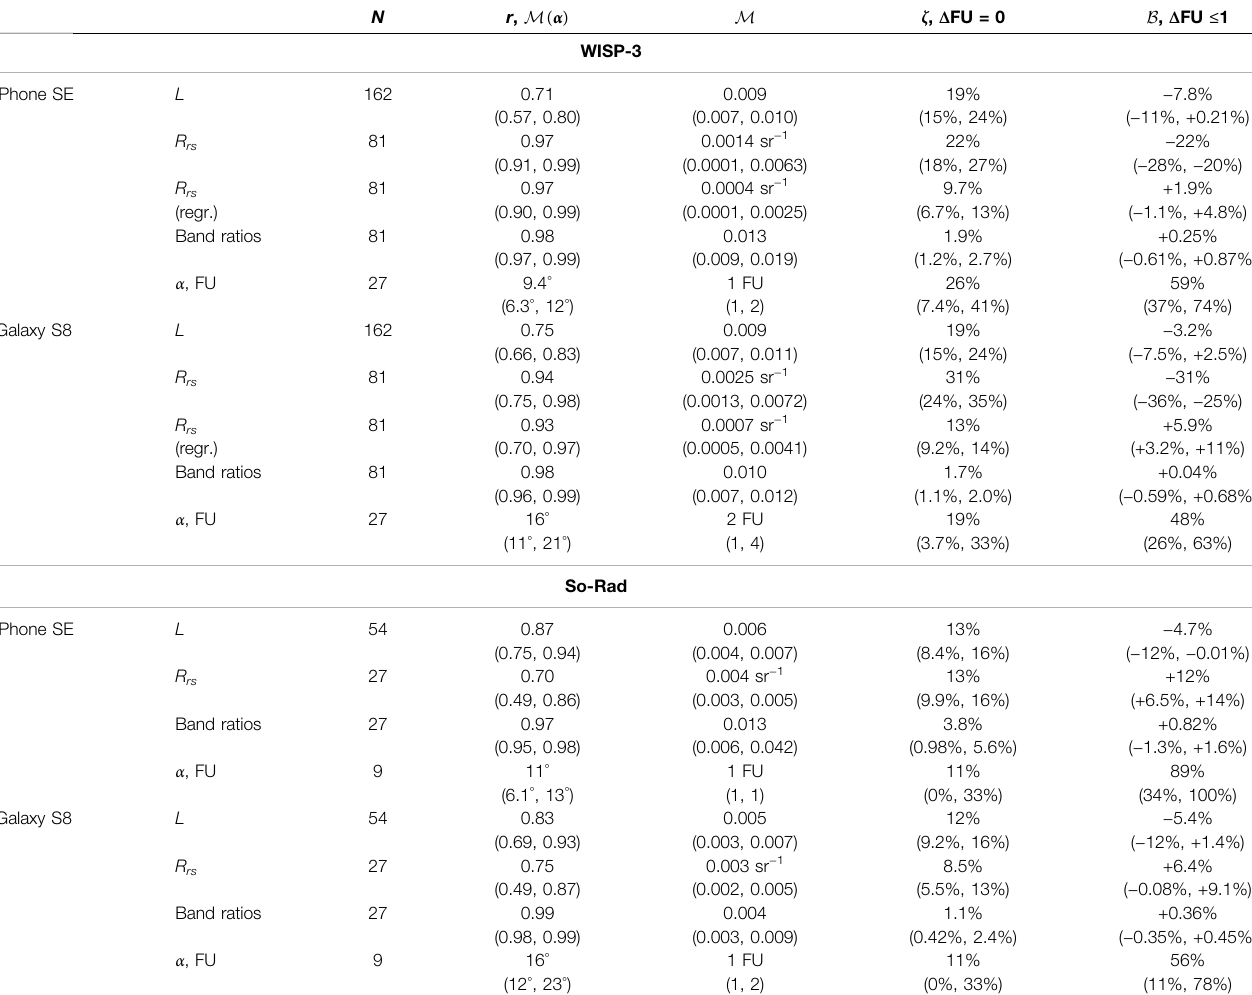
TABLE 1 | Summary of the smartphone vs. reference match-up analysis. The values between parentheses indicate the 5 – 95% CI determined from bootstrapping. N is the numberofmatchingobservations; theothermetricsaredescribed in Section2.6 . M ( L ) isinunitsofW m − 2 nm − 1 sr − 1 .FortheWISP-3, R rs wascompared1:1andwith a linear regression